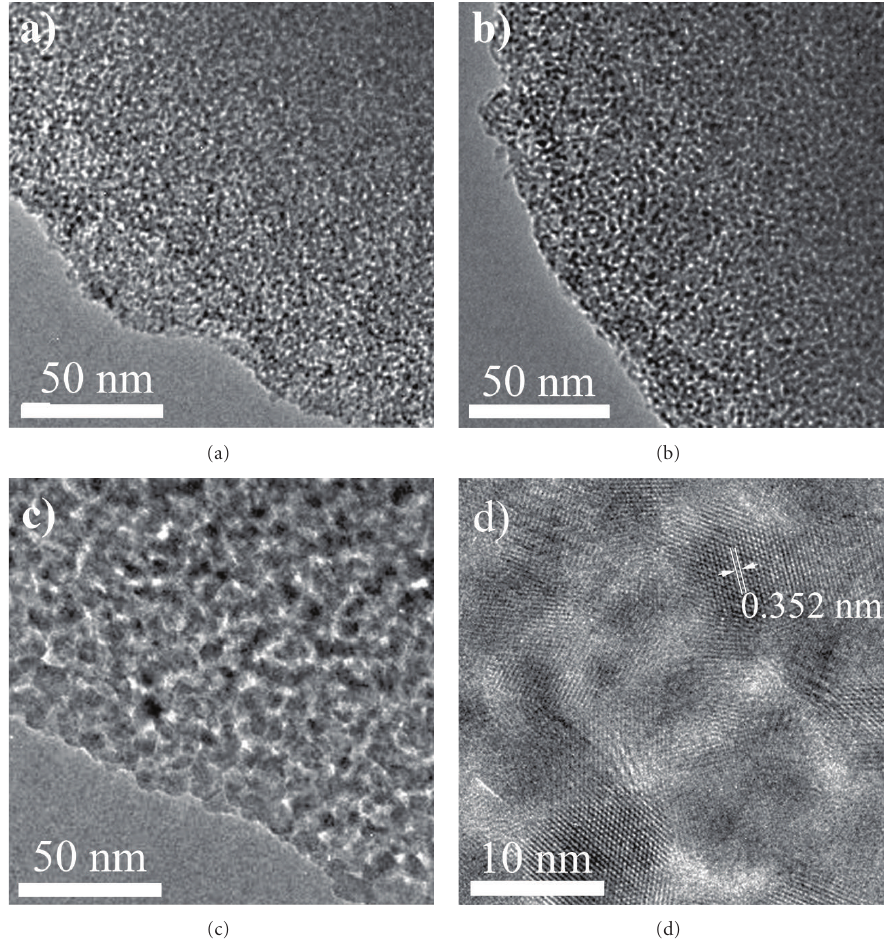
Figure 3: TEM images of (a) C-TiO 2 (UV), (b) C-TiO 2 (200), (c) TiO 2 (500), and (d) HRTEM image of TiO 2